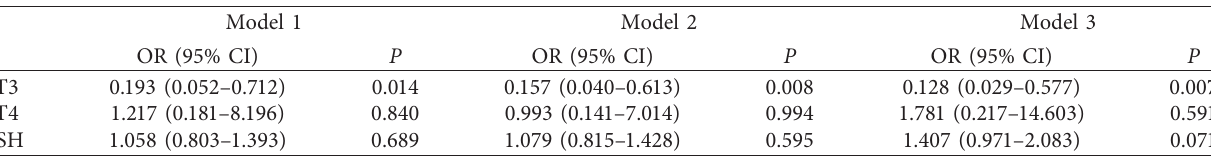
Model 1: unadjusted; Model 2: adjusted for age, sex, and BMI; Model 3: Model 2+TPOAb and TGAb, and FT3, FT4, and TSH adjusted for each